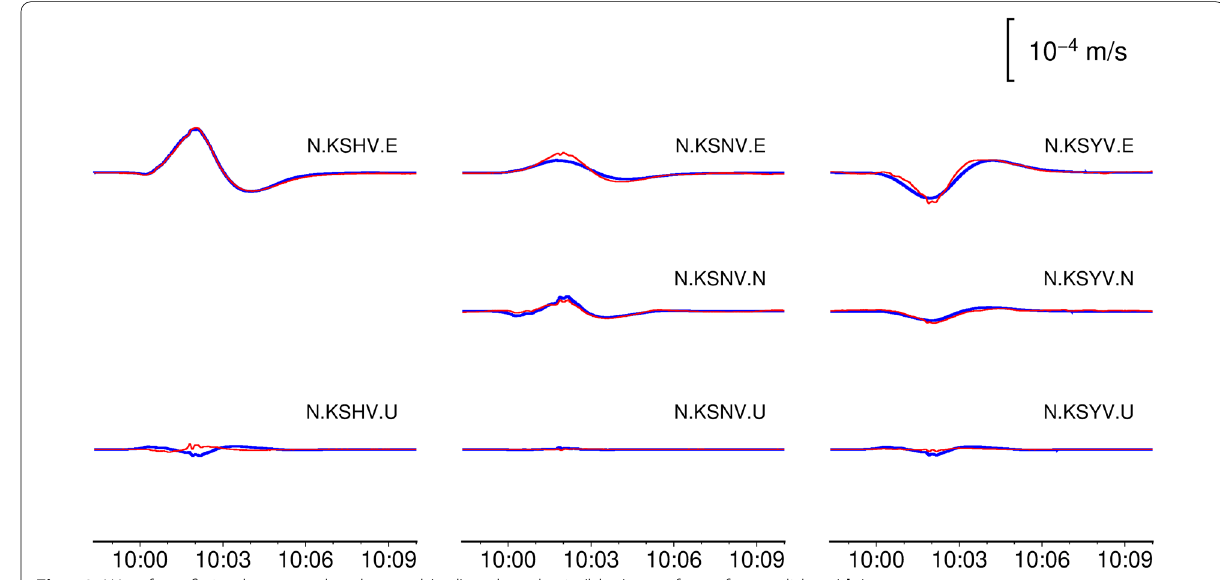
Fig. 13 Waveform fitting between the observed (red) and synthetic (blue) waveforms for candidate ( d1